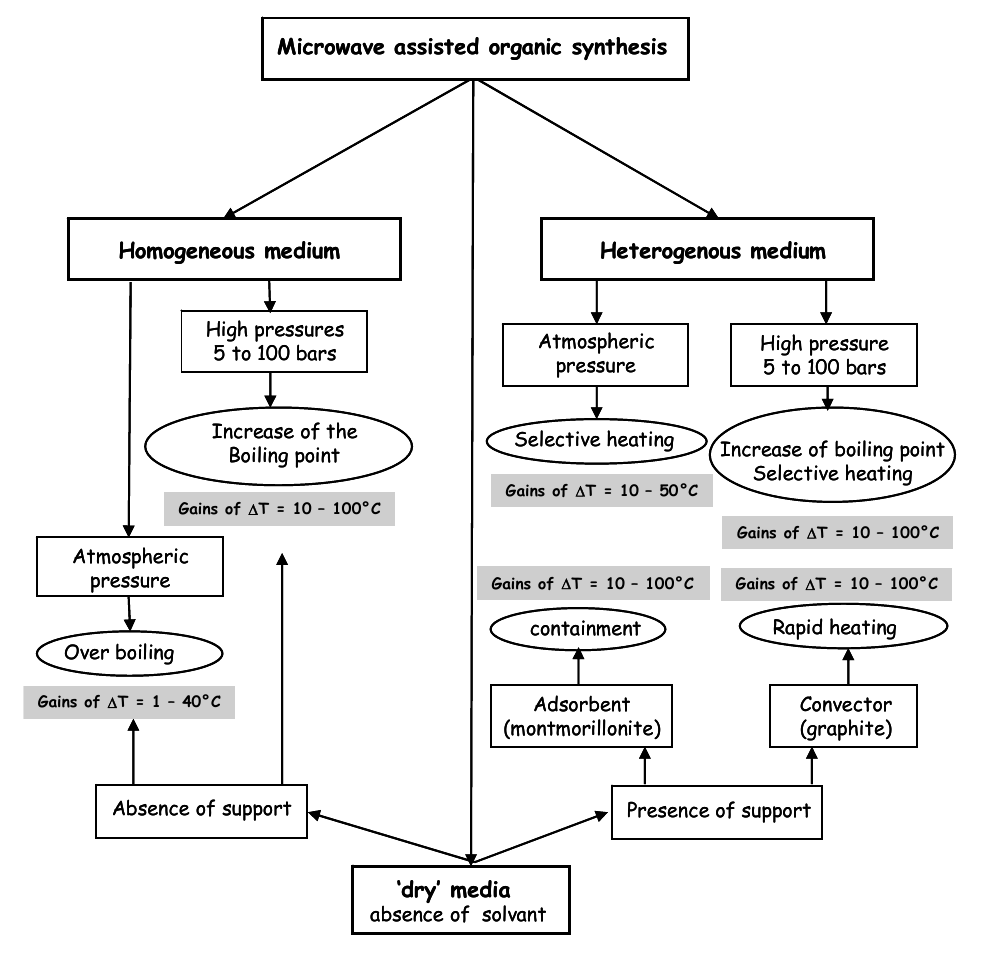
Figure 3 : Experimental procedures generally used in microwave assisted organic